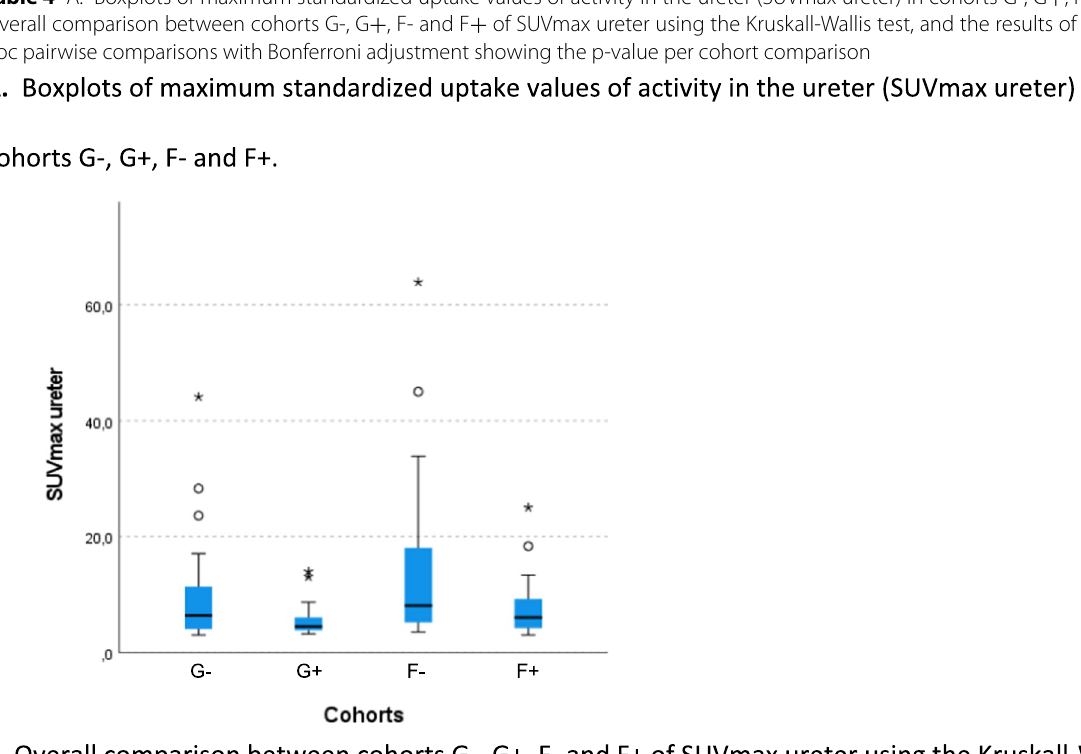
Table 4 A. Boxplots of maximum standardized uptake values of activity in the ureter (SUVmax ureter) in cohorts G‑, G